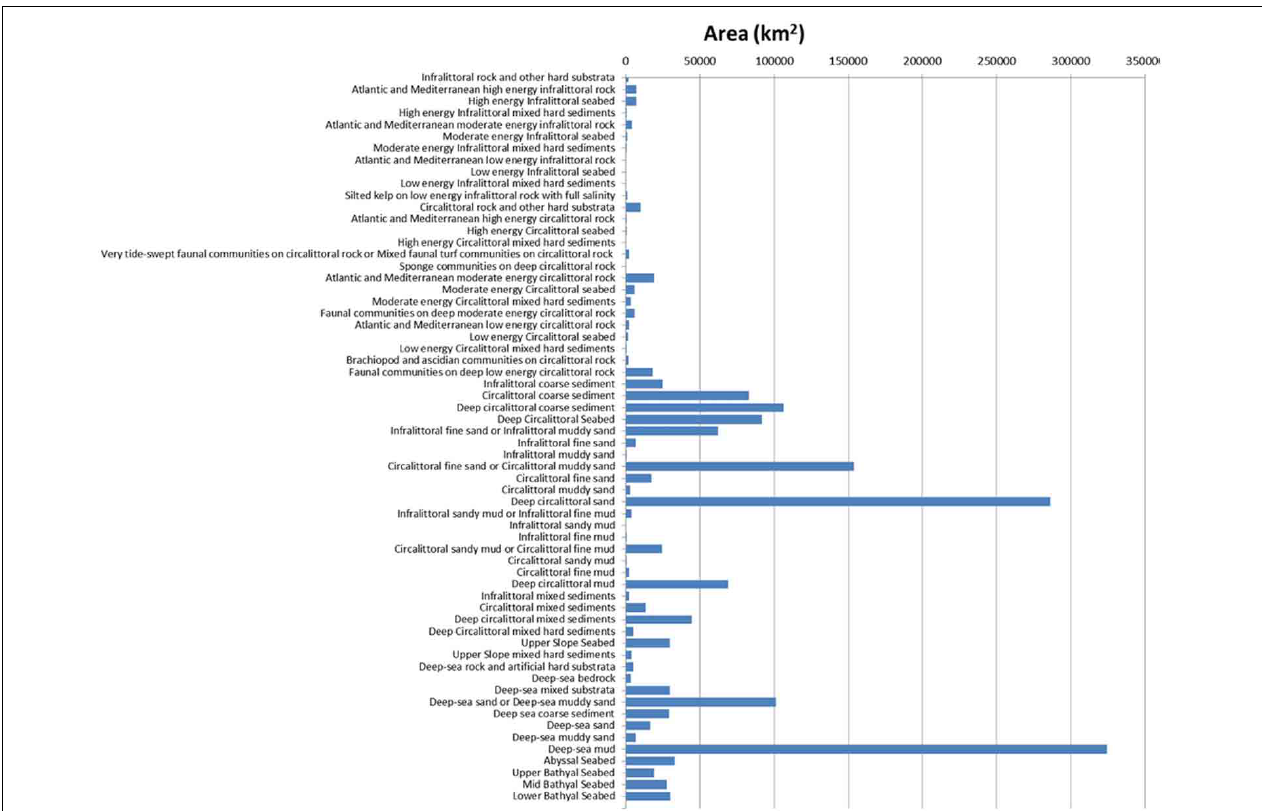
ecosystem services ( Table 3 and Figures S2 – S13 , in Supporting